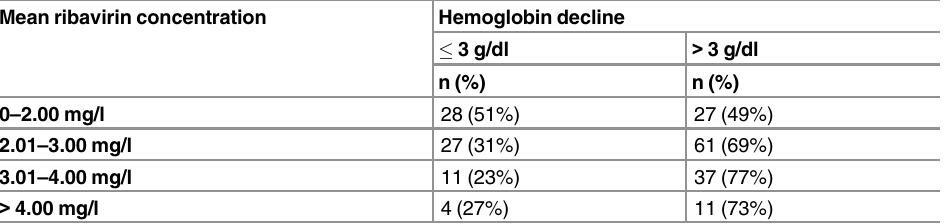
Table 5. Proportion of patients with hemoglobin decline (cid:1) 3 mg/l or > 3 mg/l in groups of increasing mean serum ribavirin